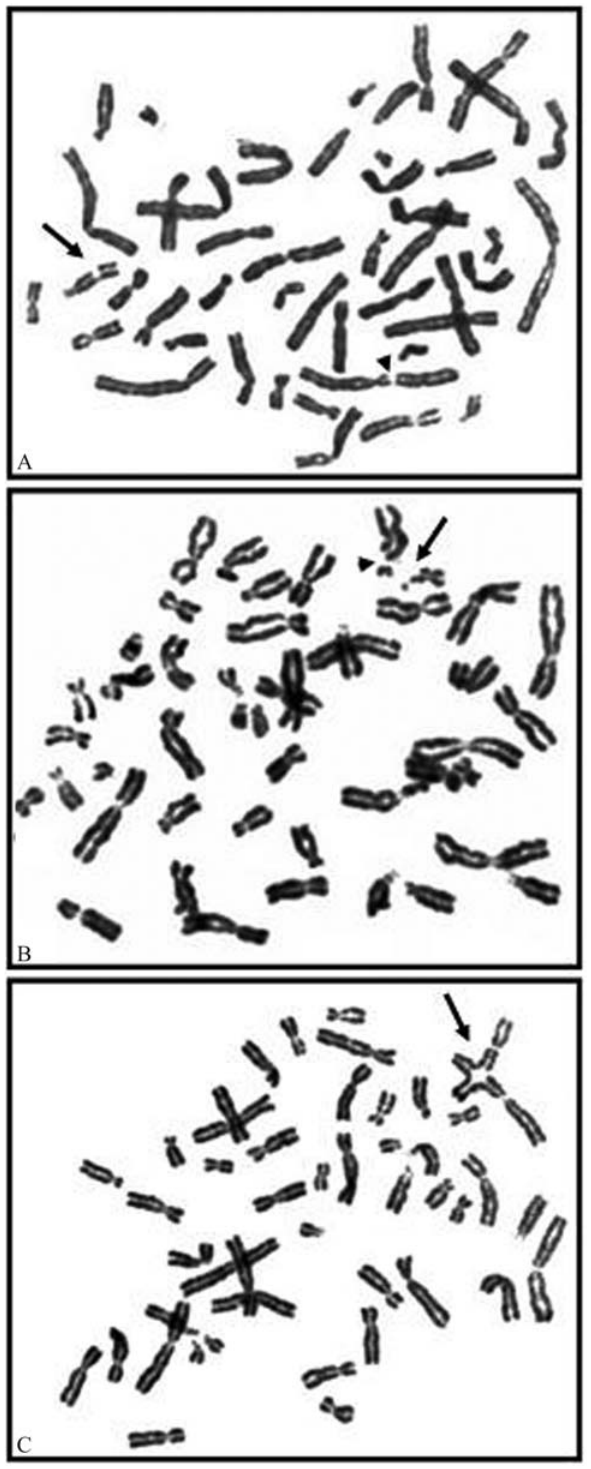
Figure 1 - Chromosomal aberrations observed in cultured human lym- phocytes treated with doxorubicin only or doxorubicin plus Fucus vesiculosus aqueous extract using different experimental protocols (pre- treatment, simultaneous-treatment and post-treatment). Arrows indicate chromatid gap ( A ), chromatid break ( B ) and quadrirradial figure ( C ). Ar- rowheads indicate chromosomal gap ( A ) and chromosomal break ( B